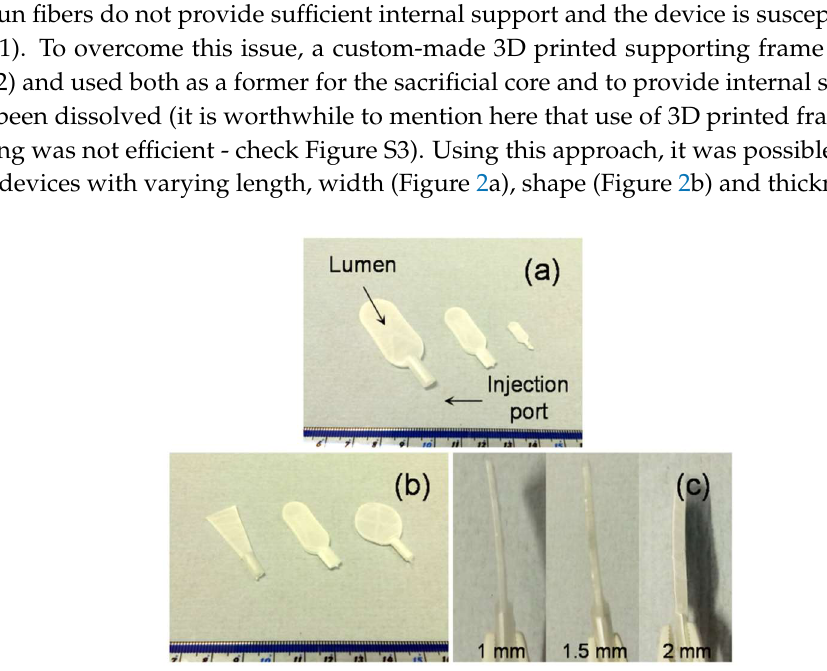
Figure 2. Sacrificial core electrospun products: With sacrificial core-based electrospinning, it was possible to prepare PA66 macro-capsules with variable size ( a ), shape ( b ), and thickness ( c ).